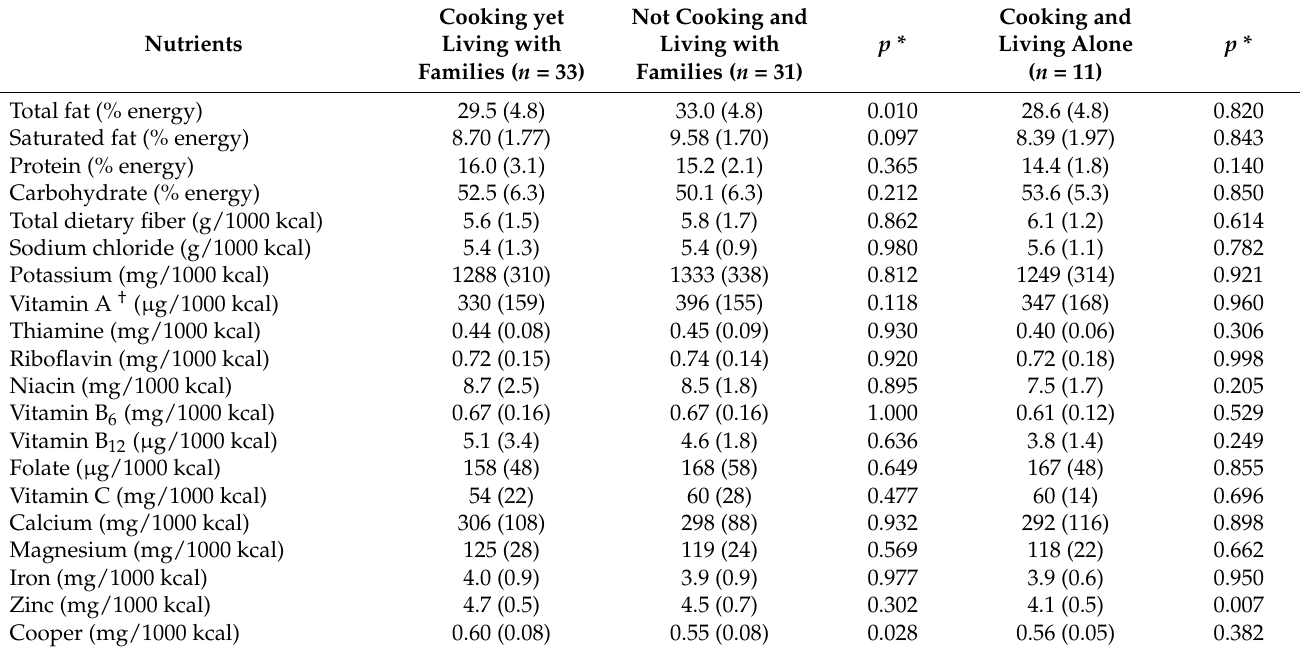
Table 3. Association of cooking with nutrient intake among female university students ( n = 75).